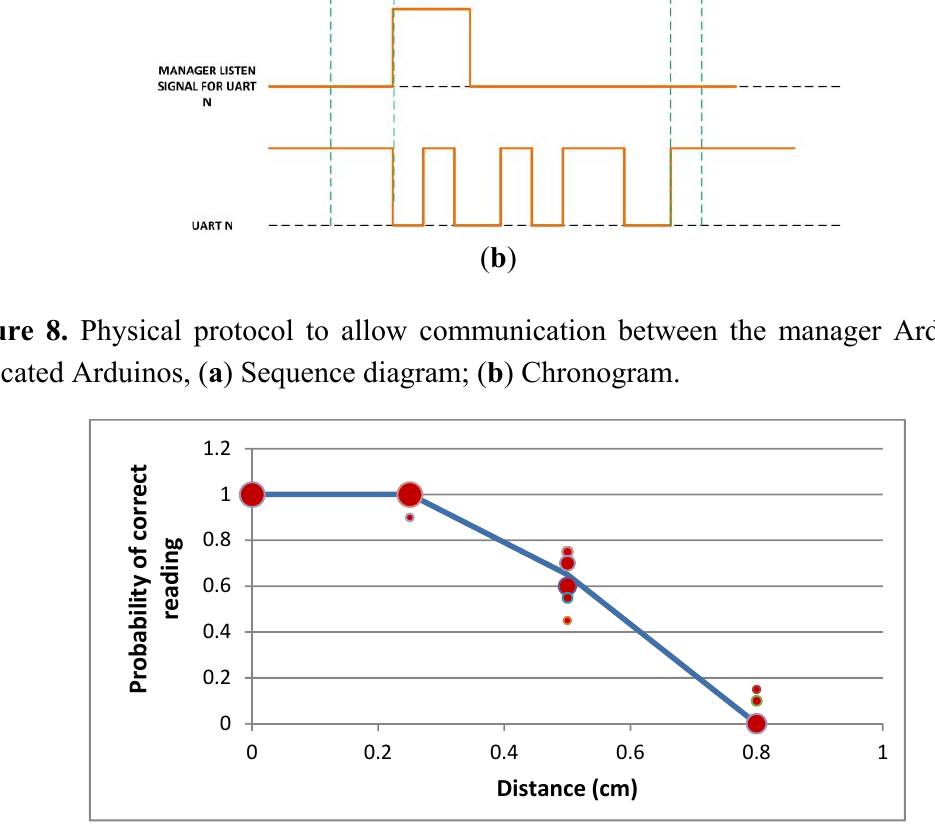
Figure 9. Evolution of the detection probability based on the distance between the table and the tagged